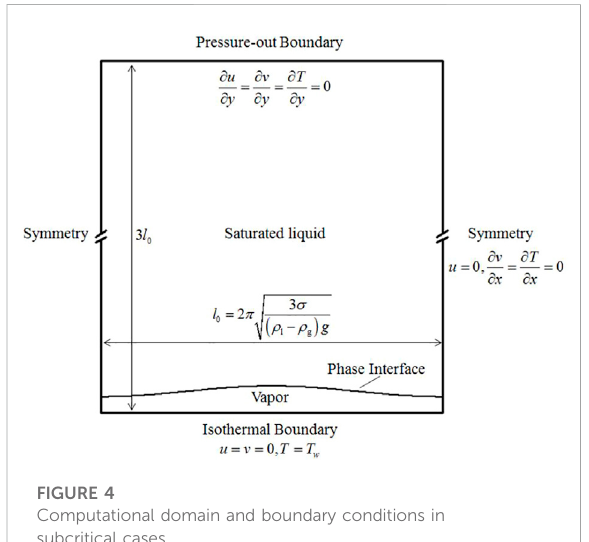
FIGURE 4 Computational domain and boundary conditions in subcritical